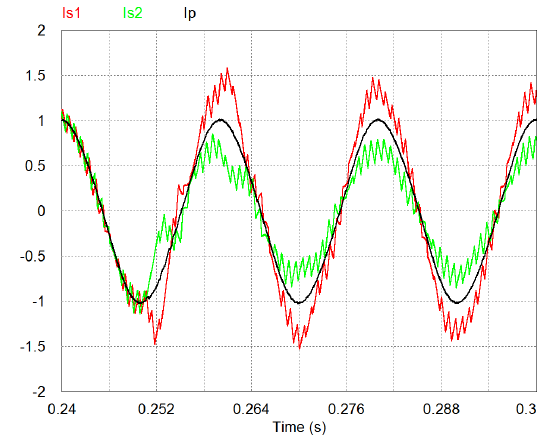
Figure 17. Synchronization loss between converters 1 and 2, starting at t =0.3 s. Traces: Is1 - AC current of converter 1, Is2 - AC current of converter 2, Ip - primary current.